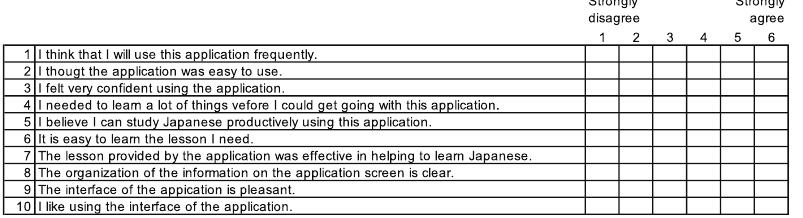
Figure 10. The questionnaire used to test